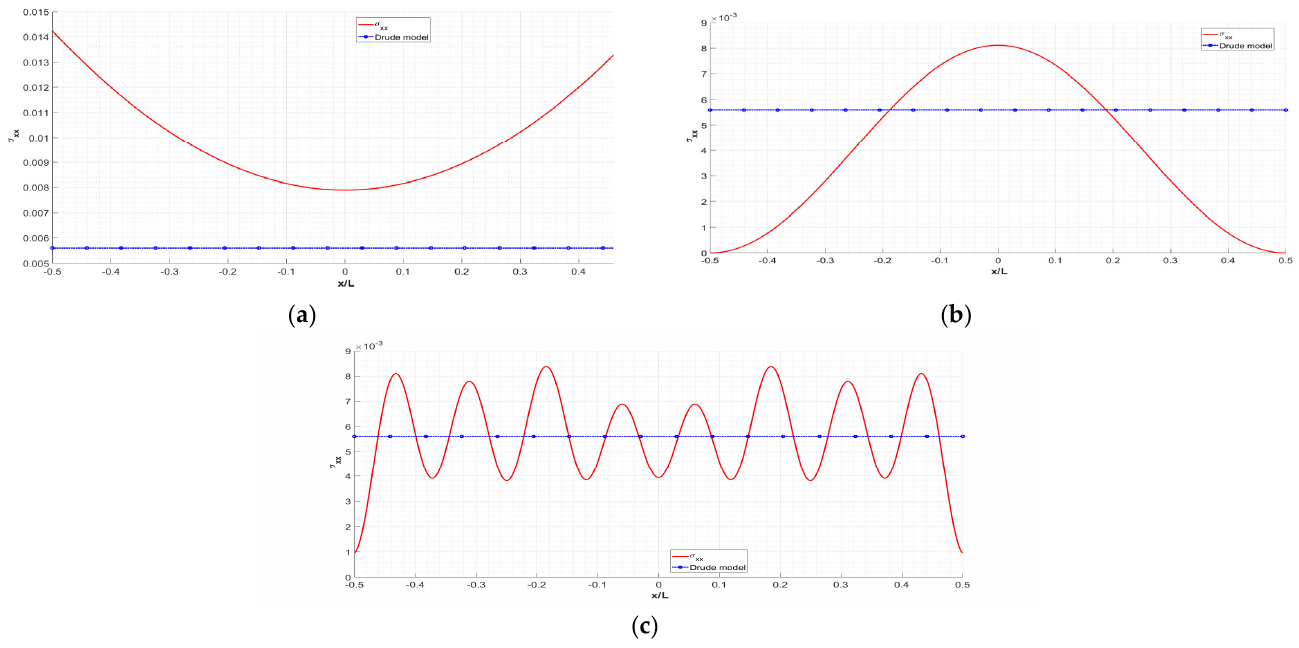
G Ll for different values of Drude